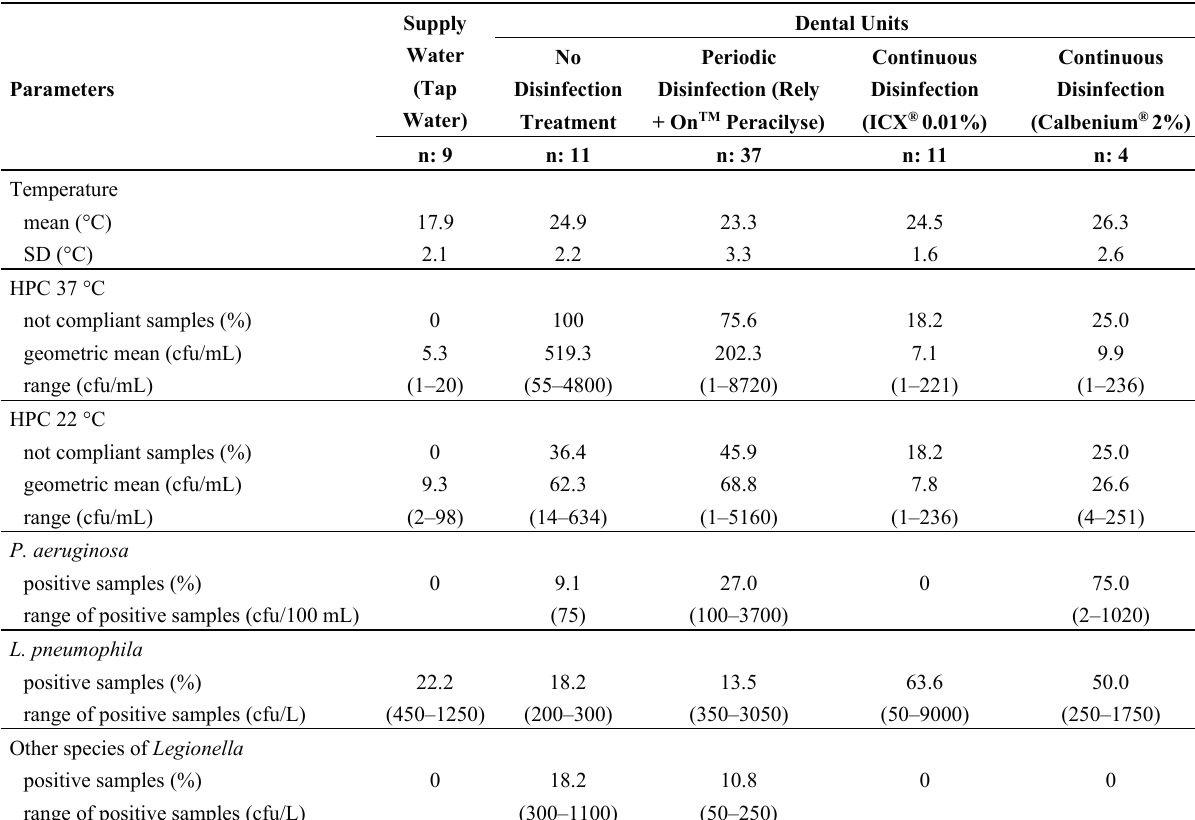
Table 4. Microbial contamination values of water samples from supply water and dental unit water systems at